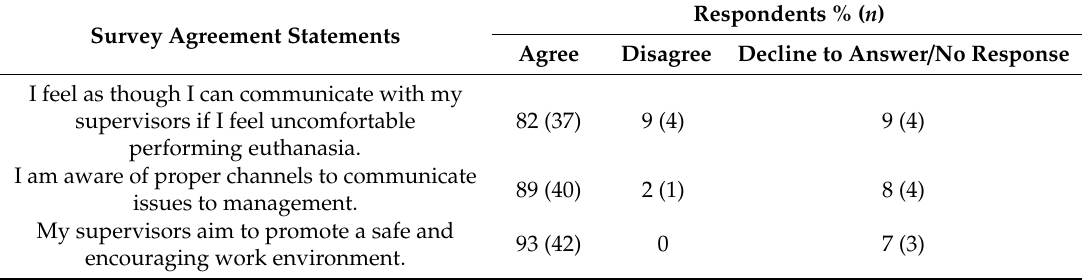
Table 5. Agreement statements related to work environment and communication in the workplace ( n = 45).